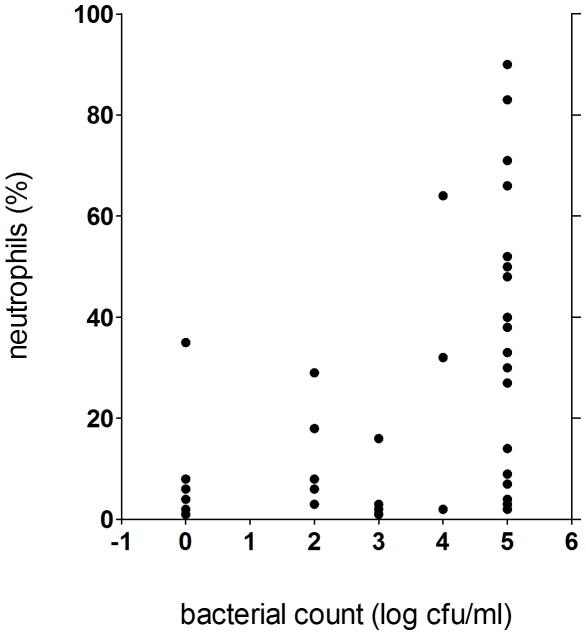
Correlation between bacterial and neutrophilic count in the bronchoalveolar lavage fluid of patients, number of patients: n = 42, each dot represents a patient, 5 dots overlap, significance levels were calculated using Mann- Whitney- U- Test (p<0,005).